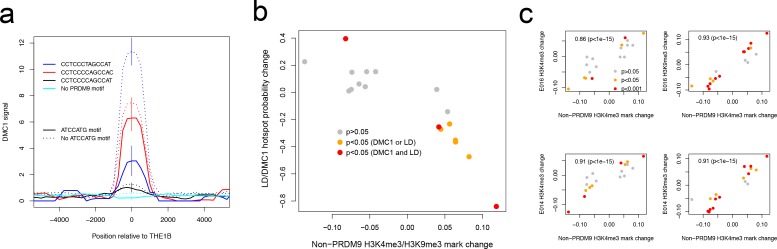
Features associated with recombination outcomes given PRDM9 binding.(a) DMC1-based recombination rates around the centers of THE1B repeats containing different approximate matches to the PRDM9 binding motif CCTCCC[CT]AGCCA[CT] (colors) and the motif ATCCATG (lines dotted if absent). ATCCATG presence reduces recombination. Vertical lines: ±2 s.e. (b) For 18 motifs identified to influence H3K4me3 signal strength at THE1B repeats in testes (and H3K9me3 in other cell types, see d) but not PRDM9 (Appendix 2) we fit a joint generalized linear model of each motifs effect size on H3K4me3 in testes (x-axis). For the same set of motifs, we fit two joint generalized linear models to estimate each motif’s effect size on the probability a THE1B repeat overlaps respectively a DMC1 or LD-based hotspot, and average the estimated effect sizes, corresponding to an odds ratio for each motif (y-axis). Points are colored according to whether coefficients for the second linear models differ significantly from zero (legend). The strong negative correlation on the plot implies that motifs increasing H3K9me3/H3K4me3 associate with decreased recombination, and conversely. (c) Four panels correspond to two different histone modifications H3K9me3 and H3K4me3, in two distinct somatic embryonic stem cell types (E014 and E016) studied by ROADMAP (Kundaje et al., 2015) and labeled accordingly on the y-axis. In each panel the x-axis is as for b. Each y-axis gives estimated coefficients under a generalized linear model fitted in the same way as the x-axis (Appendix 2), predicting enrichment of that particular histone modification in a particular cell type in THE1B repeats by presence/absence of each motif. Points are colored according to whether coefficients for this linear model differ significantly from zero (legend). Note strong positive correlations (each plot is labeled with rank-based correlation and p-value of rank-based correlation test) of 0.86 to 0.93, slightly higher for H3K9me3 than H3K4me3 and showing larger coefficients. The same motifs are then associated with both H3K9me3 and H3K4me3 changes across cell types including the cells lacking PRDM9 expression.